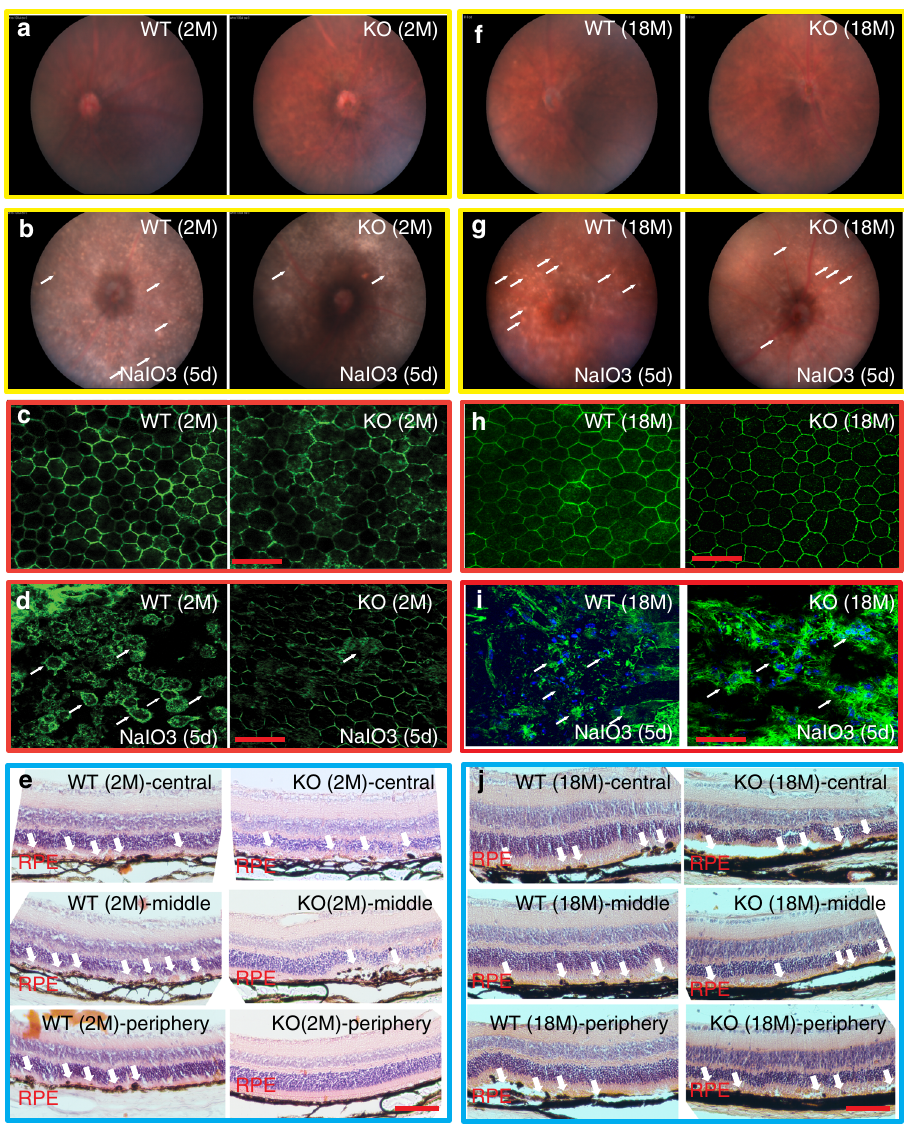
Fig. 7 Pgam5 deletion protects RPE cells from oxidative stress in young but not old mice. a Normal fundus in 2-months-old WT (left panel) and Pgam5 − / − (right panel) mice. b Fundus of 2-months-old WT (left panel) and Pgam5 − / − (right panel) mice at 5 days after NaIO 3 injection. Arrows point to the “ white spots ” that represent degenerated RPE. c ZO-1 staining of the retinal fl atmount in 2-months-old WT (left panel) and Pgam5 − / − (right panel) mice. Scale bar = 50 µ m. d ZO-1 staining of the retinal fl atmount in 2-months-old WT (left panel) and Pgam5 − / − (right panel) mice at 5 days after NaIO3 injection. Scale bar = 50 µ m. Arrows point to the disrupted RPE regions. e Representative H&E staining of sections from 2-months-old WT and Pgam5 − / − mice at 5 days after 20 mg/kg NaIO 3 injection. Top, middle and down panels represent the central, middle and periphery regions of the retina, respectively. Scale bar = 100 µ m. Arrows point to disrupted RPE regions. f Normal fundus in 18-months-old WT (left panel) and Pgam5 − / − (right panel) mice. g Fundus of 18-months-old WT (left panel) and Pgam5 − / − (right panel) mice at 5 days after NaIO 3 injection. Arrows point to the “ white spots ” that represent degenerated RPE. h ZO-1 staining of the retinal fl atmounts in 18-months-old WT (left panel) and Pgam5 − / − (right panel) mice. Scale bar = 50 µ m. i ZO-1 staining of the retinal fl atmount in 18-months-old WT (left panel) and Pgam5 − / − (right panel) mice at 5 days after NaIO3 injection. Scale bar = 50 µ m. Arrows point to the disrupted RPE regions. j Representative H&E staining of sections from 18-months-old WT and Pgam5 − / − mice at 5 days after 20 mg/kg NaIO 3 injection. Top, middle and down panels represent the central, middle and periphery regions of the retina, respectively. Scale bar = 100 µ m. Arrows point to disrupted RPE regions. n = 4 biologically independent experiments for each group in this fi gure. Images were captured under same settings, and representative images were phosphatase to dephosphorylate Drp1 mediated by Axin1. Damaged mitochondria (such as CCCP treatment) induces PGAM5 cleavage and release to cytosol, where it binds to Axin1. Drp1 (Ser-637) is also recruited to Axin1 and subsequently dephosphorylated by PGAM5. The dephosphorylated Drp1 binds to mitochondria and promotes mitochondrial fi ssion and turn- over, therefore removing the damaged mitochondria. PGAM5